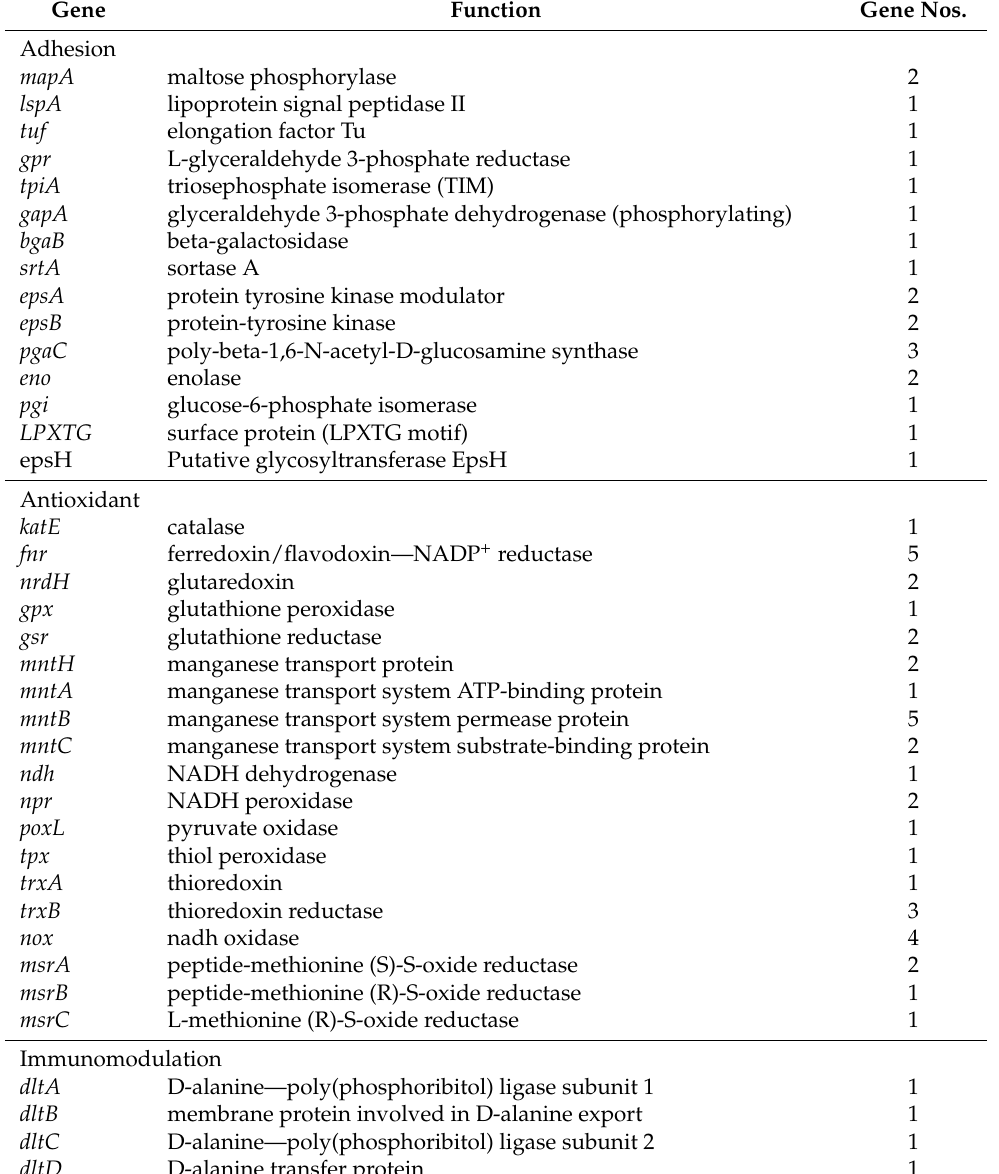
Table 4. Cont . Gene Function Gene